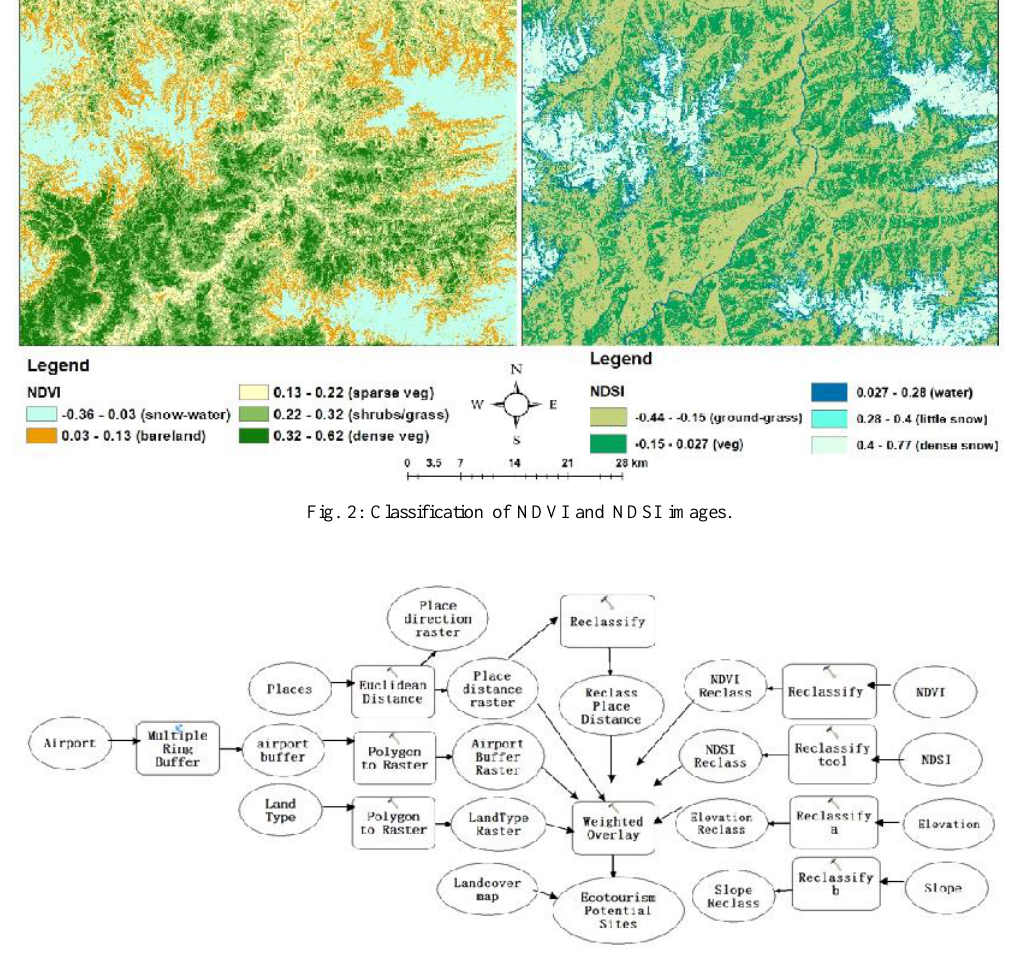
Fig. 3: Eco tourism potential site analysis